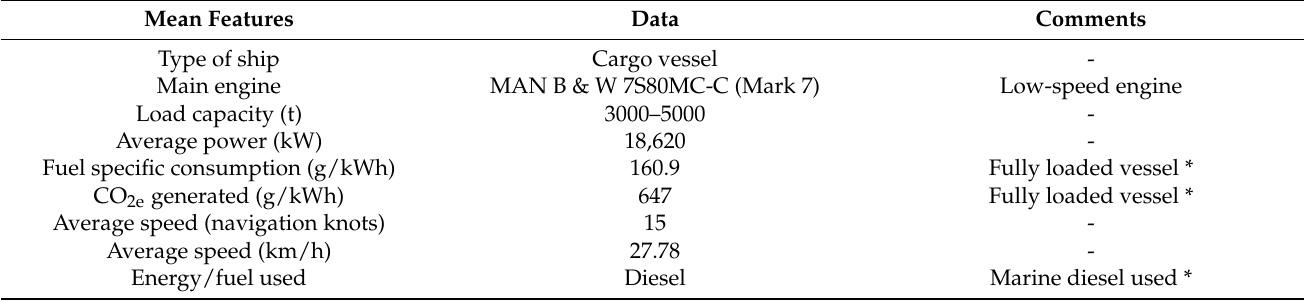
Table 9. Marine transport used for long-distance shipments of goods [51–54].